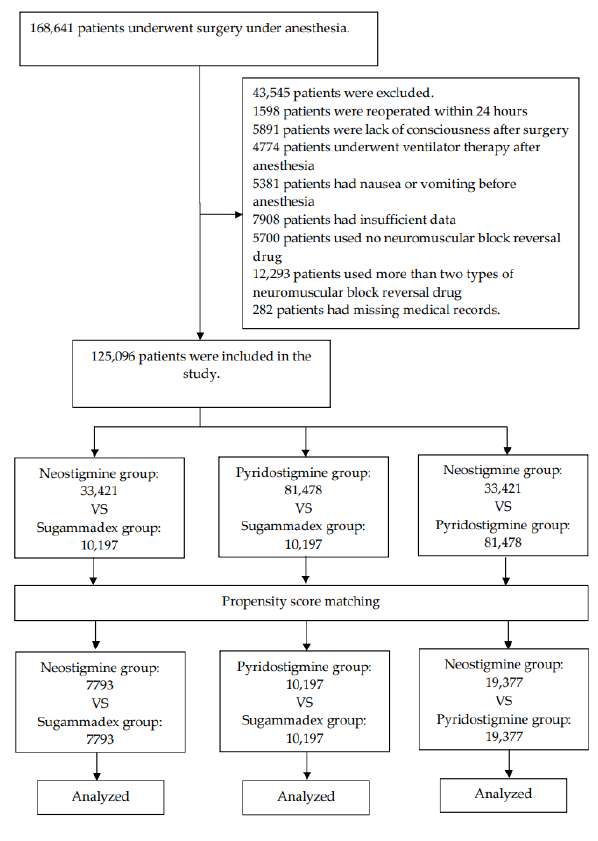
Figure 1. Flow chart.